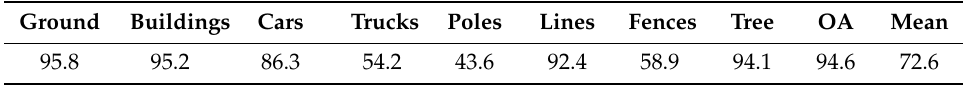
Table 2. Overview of the proposed method on the DALES data set. We report the overall accuracy, mean IoU and per class IoU, for each category (All values are in